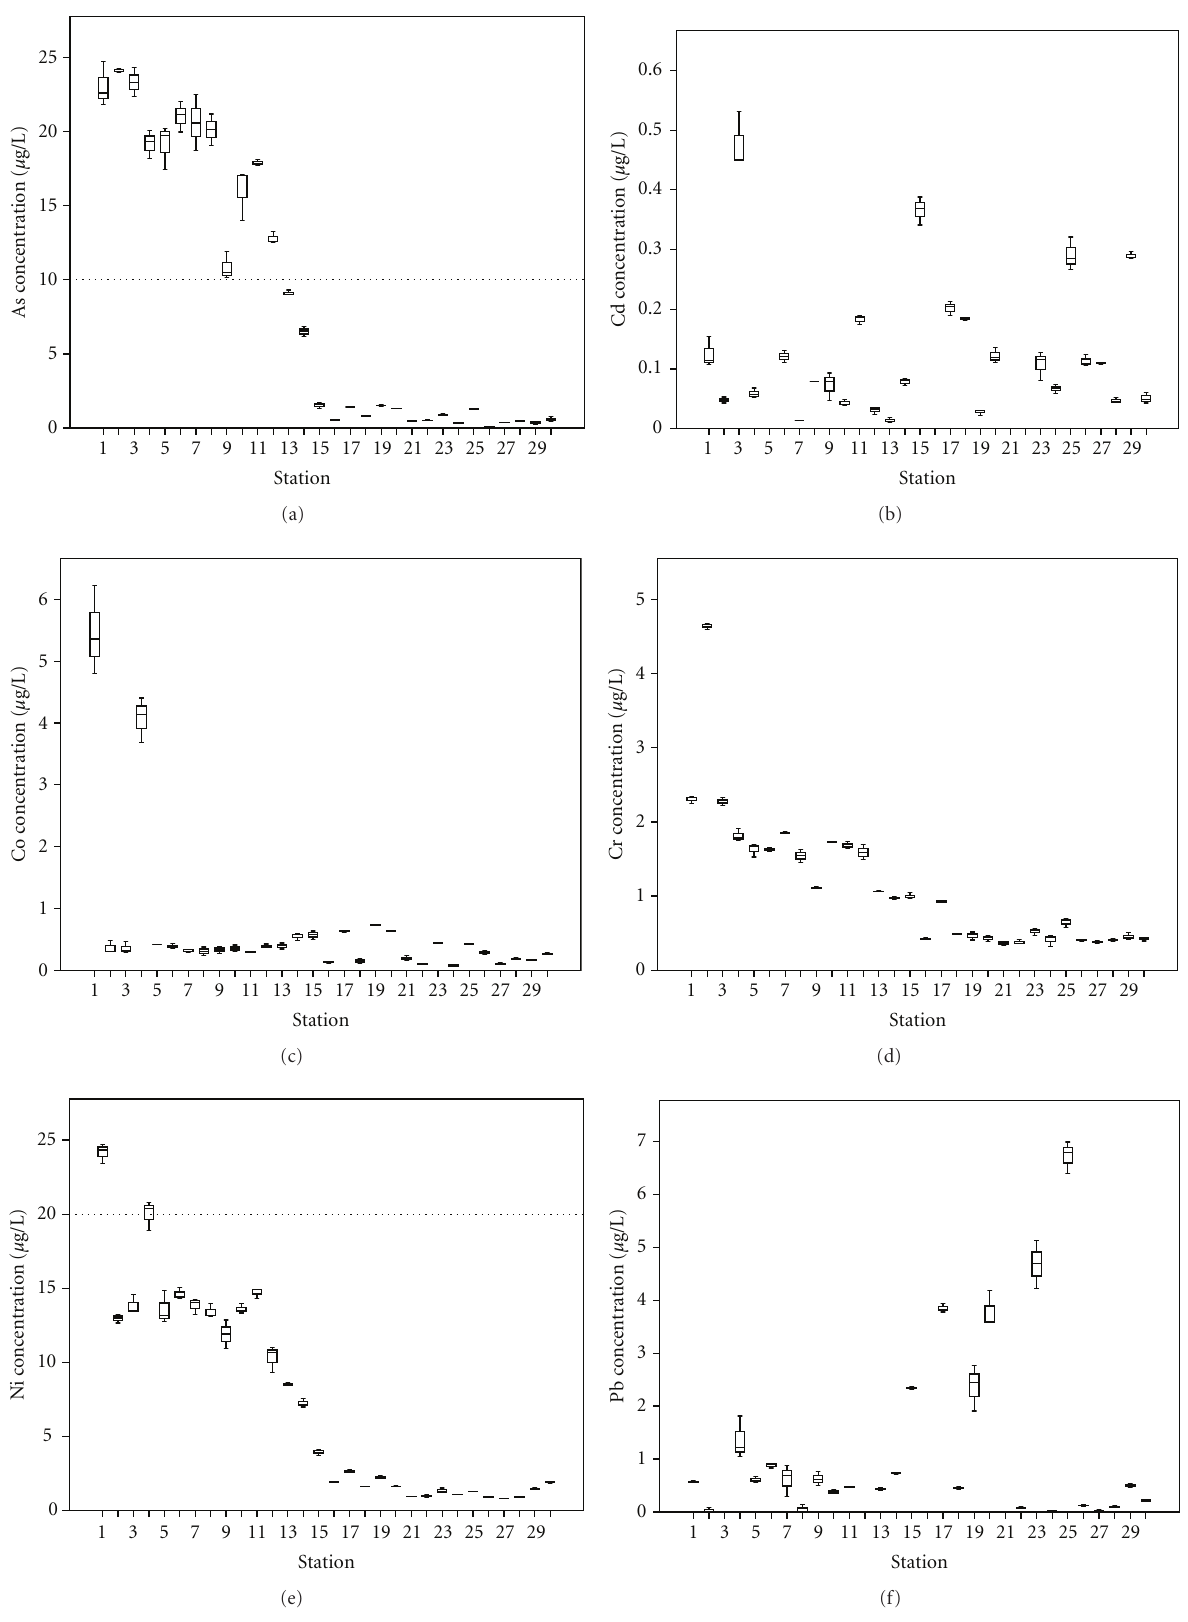
Figure 4: Distribution of each heavy metal concentration ( µ g/L) along stations in Langat River water samples by comparing with Malaysian National Standard for Drinking Water Quality